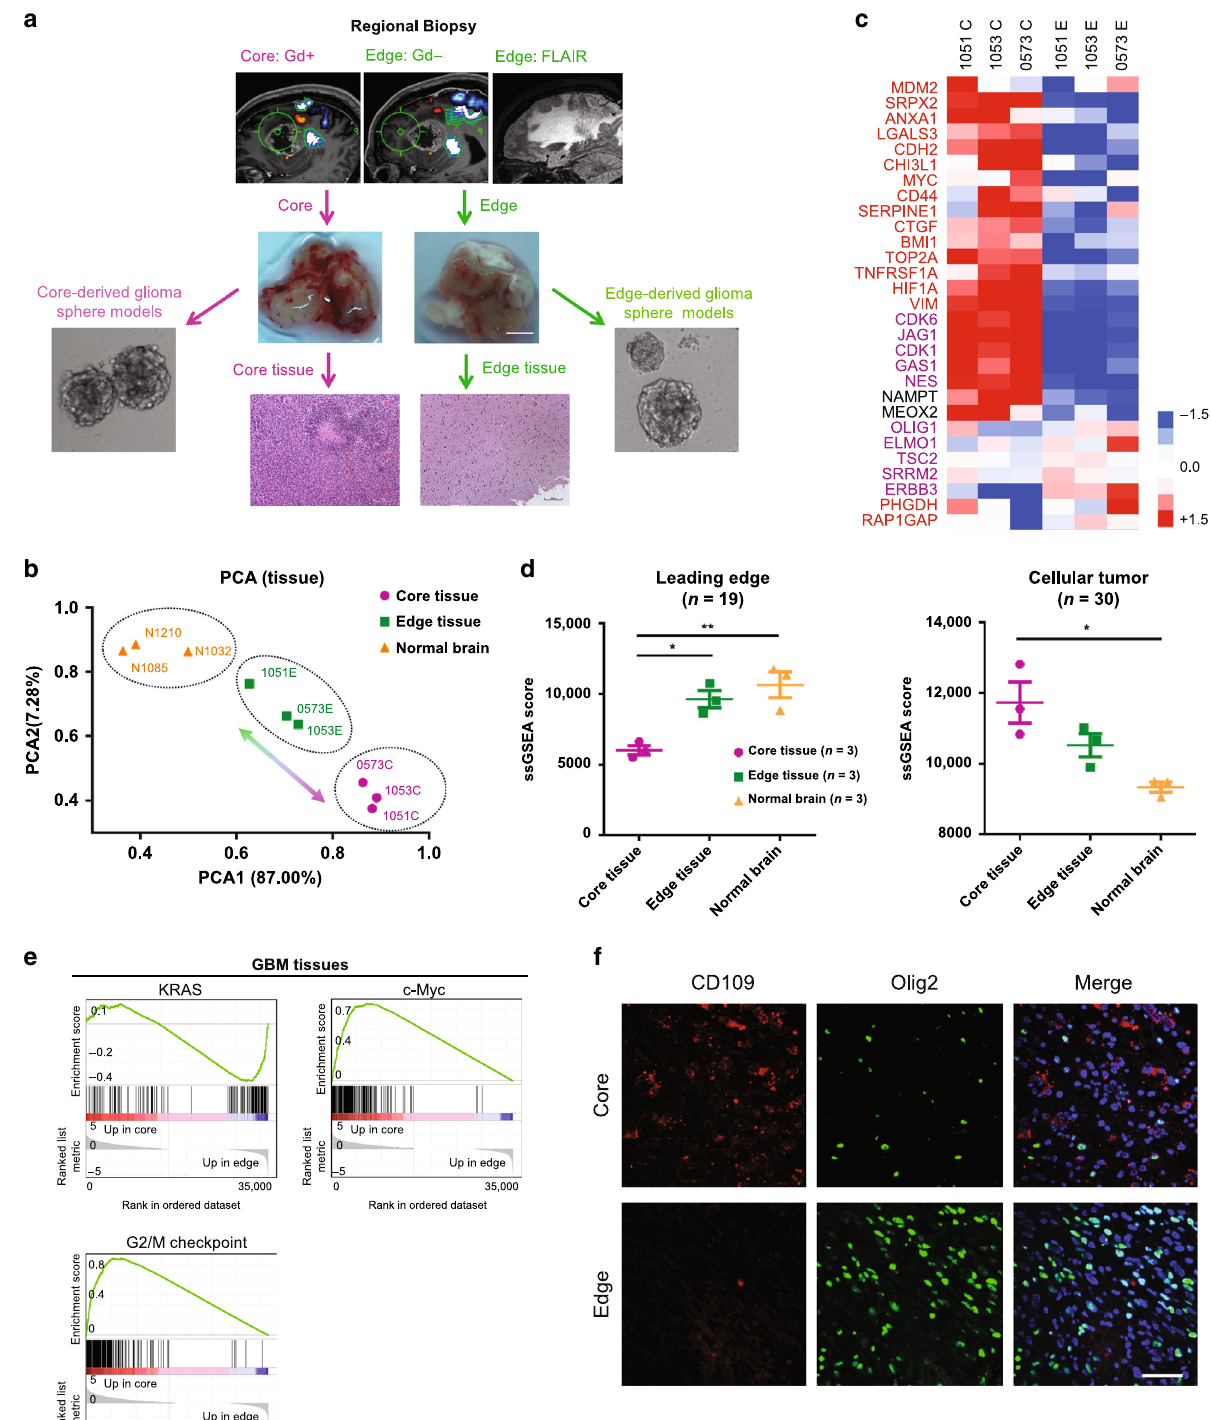
To further compare edge/core signatures in association with the conventional transcriptomic subtypes, we tested the relation- ship between the transcriptional subtypes of GBM (PN, MES, or Classical (CL)) and the presence of proposed edge and core markers. We performed IHC staining of tissue microarrays from 61 GBM patients (PN = 31 patients, MES = 10 patients, CL = 11 patients, unclassi fi ed = 9 patients) with antibodies against Olig2 and CD109 (Supplementary Fig. 1e). Analysis showed